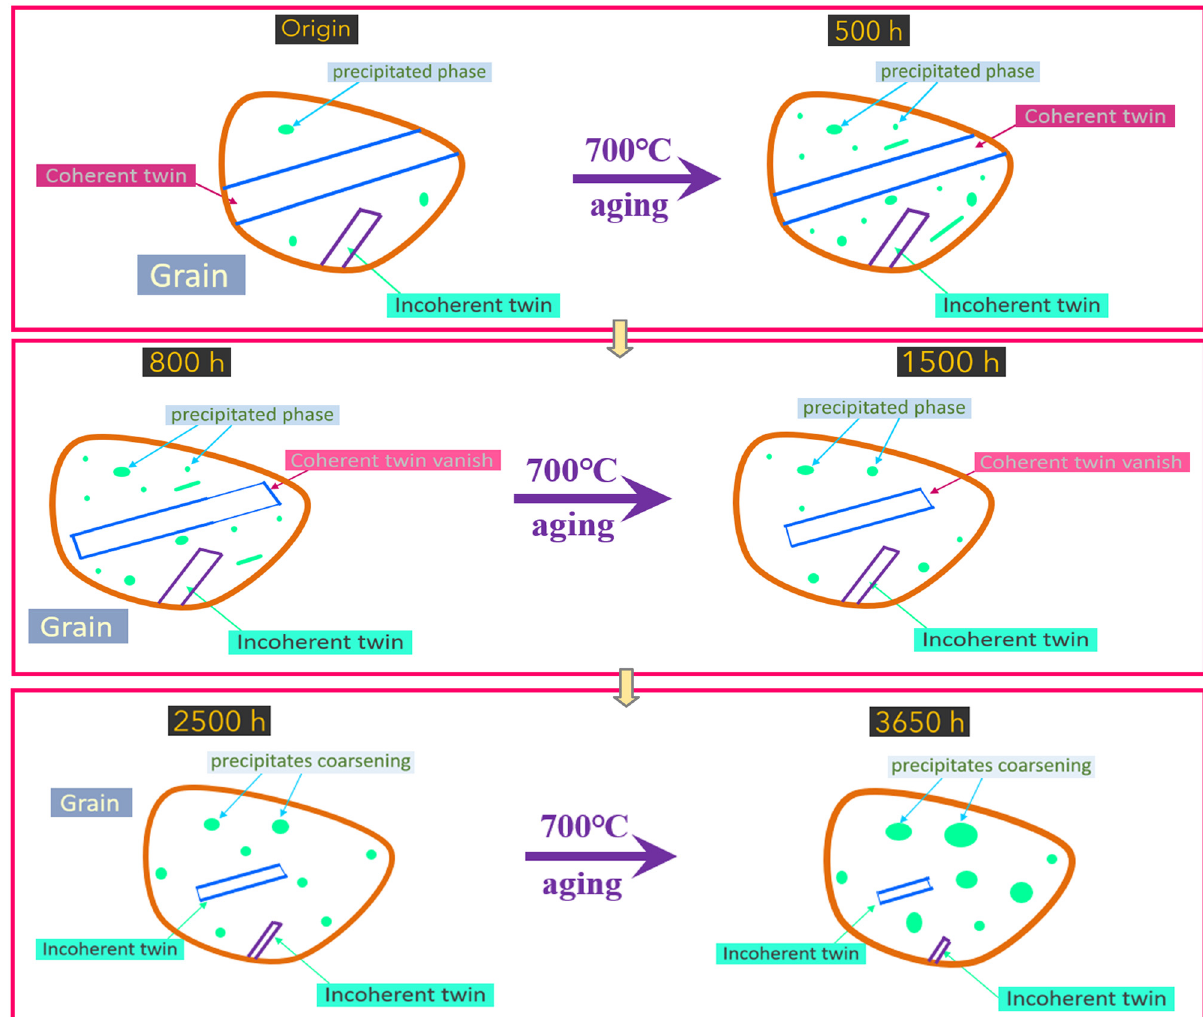
Figure 7: Illustration of microstructure variation of the TP347HFG steel during the aging